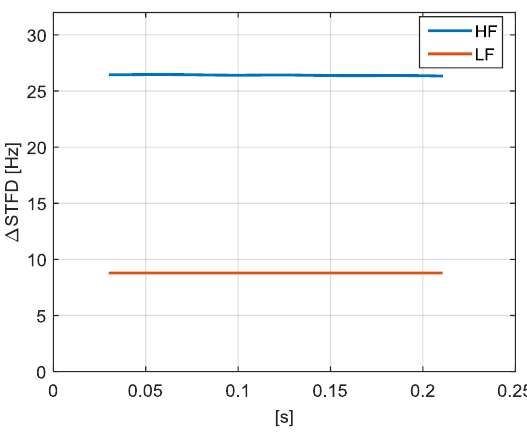
(2 ÷ 150 kHz, blue line) obtained by the late approach. Energies 2017 , 10 , 1633 14 of 39